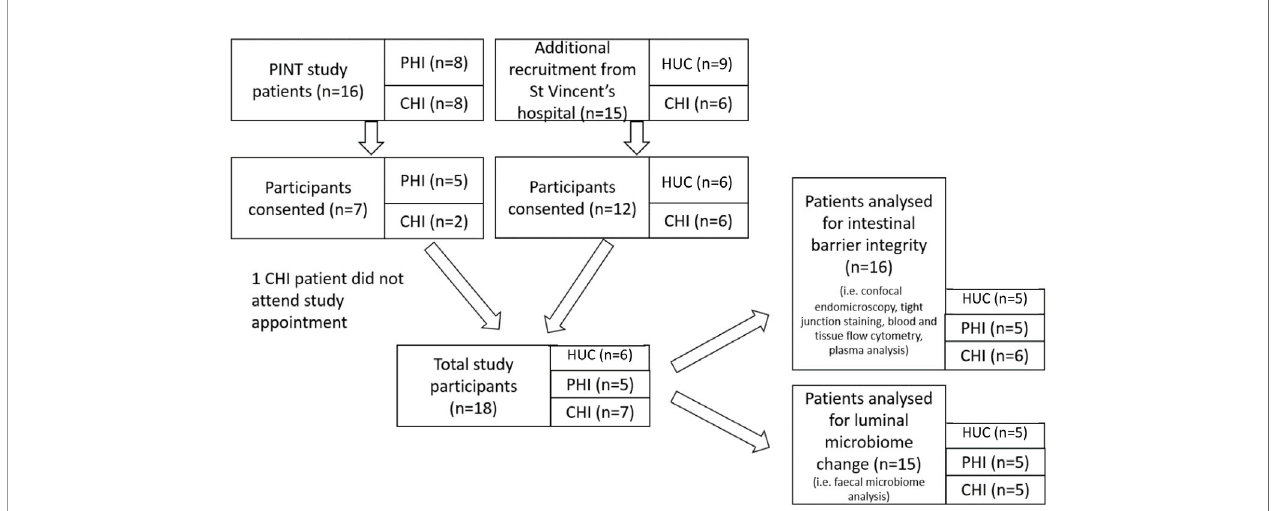
FIGURE 2 | Patient recruitment fl owchart outlining selection of patients for confocal endomicroscopy imaging, tight junction, blood and tissue lymphocyte, plasma marker and faecal microbiome analyses. HUC, HIV-uninfected control; PHI, HIV-positive participant who initiated antiretroviral therapy during primary HIV infection; CHI, HIV-positive participant who initiated antiretroviral therapy during chronic HIV